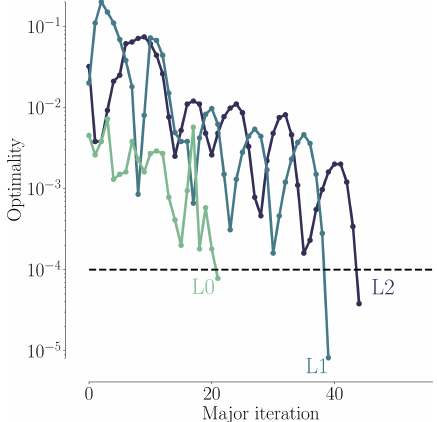
Figure 11. Convergence history for all three mesh levels.